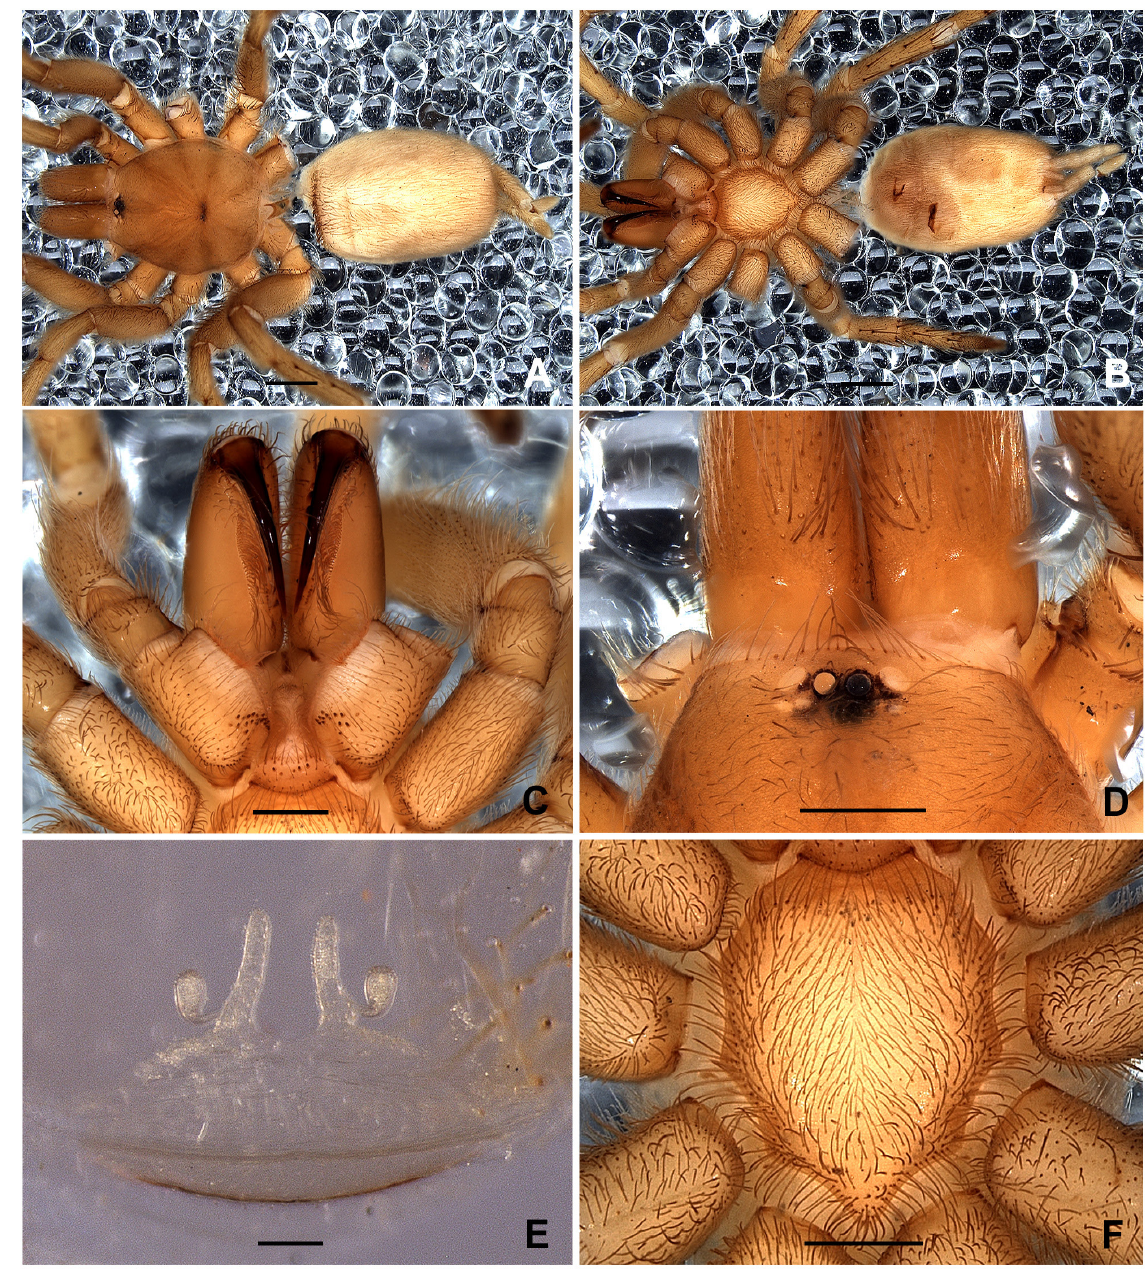
Fig. 5. Ammonius pupulus Thorell, 1899, ♀ (RMCA 227221). A . Habitus dorsal. B . Habitus ventral. C . Maxillae and labium, ventral view. D . Eye group, dorsal view. E . Spermathecae. F . Sternum, ventral view. Scale bars: A–B = 1 mm; C–D, F = 0.5 mm; E = 0,02